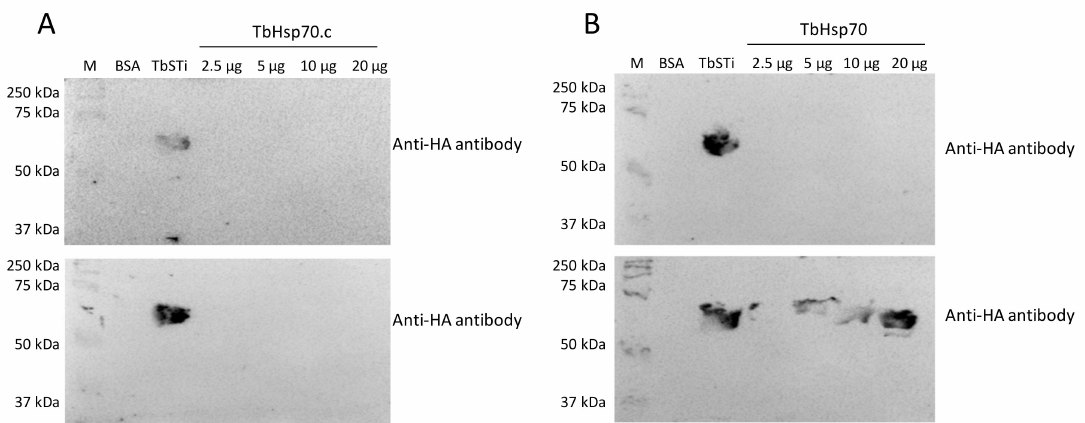
Figure 6. TbSTi1 interacts with TbHsp70 but not with TbHsp70.c. Far western analysis was used to investigate the interactions between TbHsp70.c ( A ) and TbHsp70 ( B ) with TbSTi1. BSA (20 µ g/mL) as negative control protein, TbSTi1 (20 µ g/mL) as positive control protein, and TbHsp70 or TbHsp70.c proteins at various concentrations (2.5 µ g/mL, 5 µ g/mL, 10 µ g/mL, and 20 µ g/mL) were resolved by SDS-PAGE and transferred to the respective blots that were then probed using anti-HA antibody (top panel), an epitope of TbSTi1. Similarly transferred blots were overlaid with TbSTi1 then also probed with anti-HA antibody (bottom panel). The blots are representative of independent